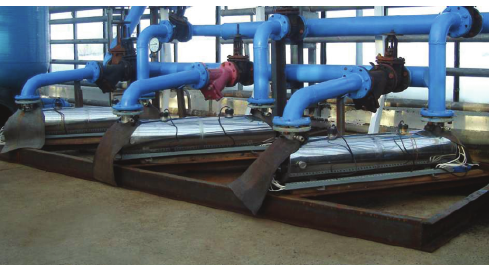
Figure 8: Multilamp reactors of “Lasur”